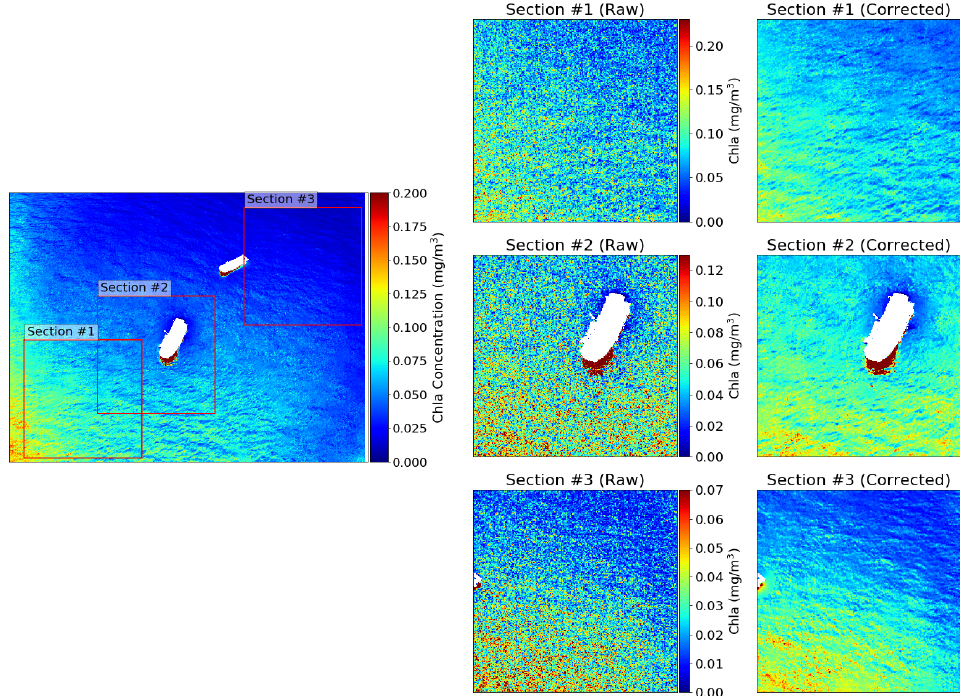
Figure 14. Comparison of resultant Chla estimates for Scene-A (altitude 85.4 m), before and after the application of the proposed morphological band registration method. Three subsections were magnified for improved visual evaluation.